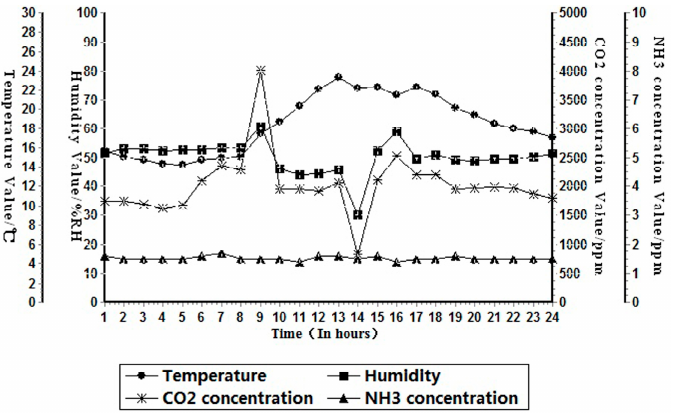
Figure 4. Environmental parameter variations within a day of Node